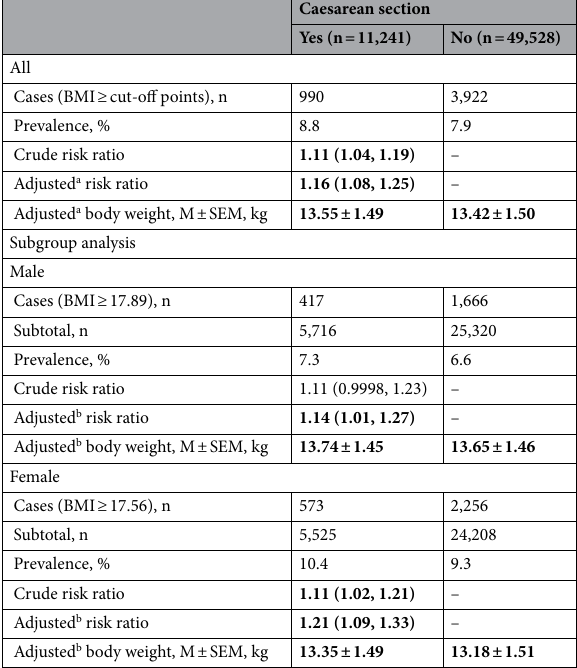
Table 2. Relationship between caesarean section birth and childhood obesity at 3 years of age according to sex (International Obesity Task Force cut-offs). a Adjusted for maternal age, pre-pregnancy BMI, highest education level, annual household income, history of smoking, alcohol consumption, pregnancy complications, obstetric complications, history of physical disease, parity, use of assisted reproduction technology, child sex, birth term, birth weight and birth height. b Adjusted for all the covariates in the model a , except child sex. Bold type indicates statistical significance at the level of p < 0.05. – indicates reference. BMI body mass